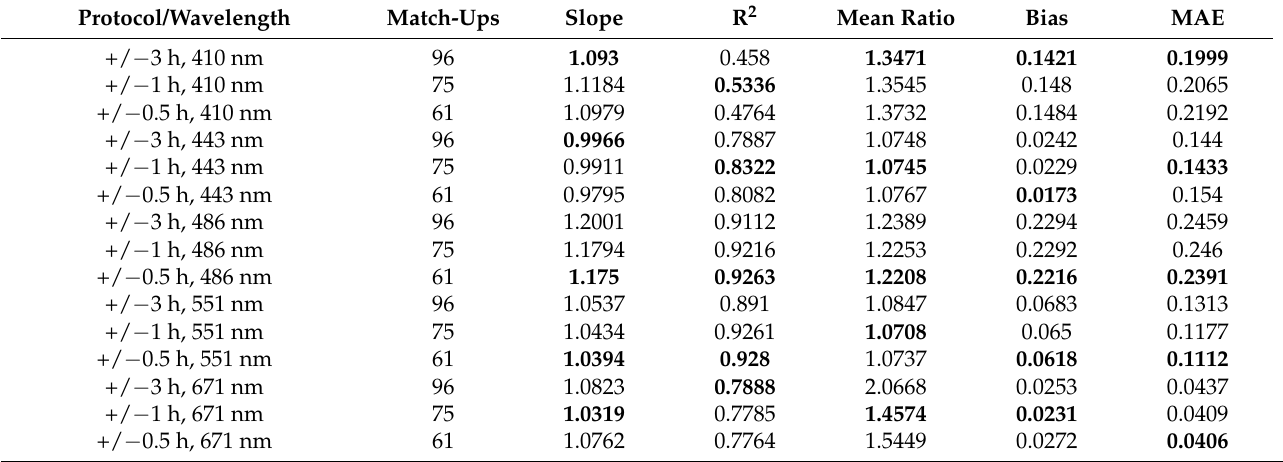
Table 6. Venise data, strict protocol. June 2014 − May 2019. Center (in situ) pixel only, at +/ − 3, 1, and 0.5 h. Values closest to one in bold, for slope, R 2 , and mean ratio. Lowest values in bold for bias and mean absolute